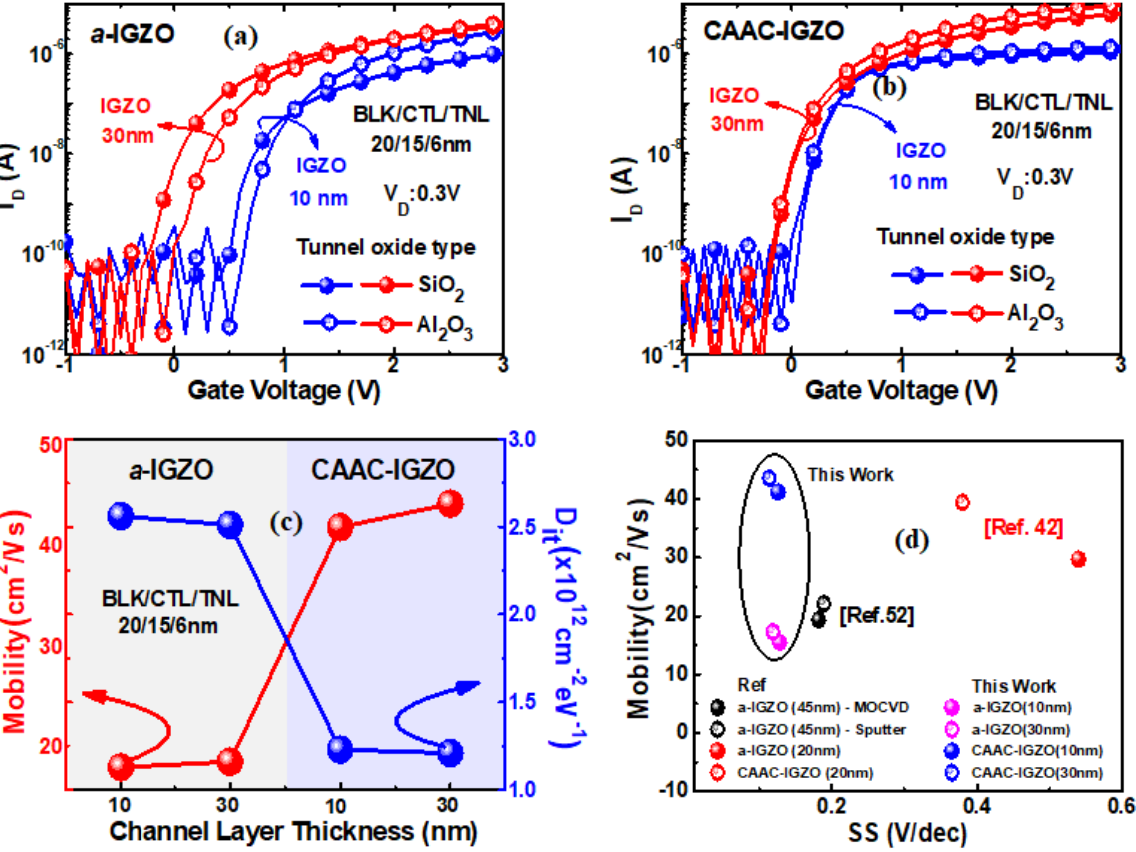
Figure 5. I d – V g comparison of the ( a ) a -IGZO and ( b ) CAAC-IGZO devices. ( c ) Dependence of the active layer thickness on µ FE and D it . ( d ) Comparison of reported IGZO-based devices with this work [42,52].